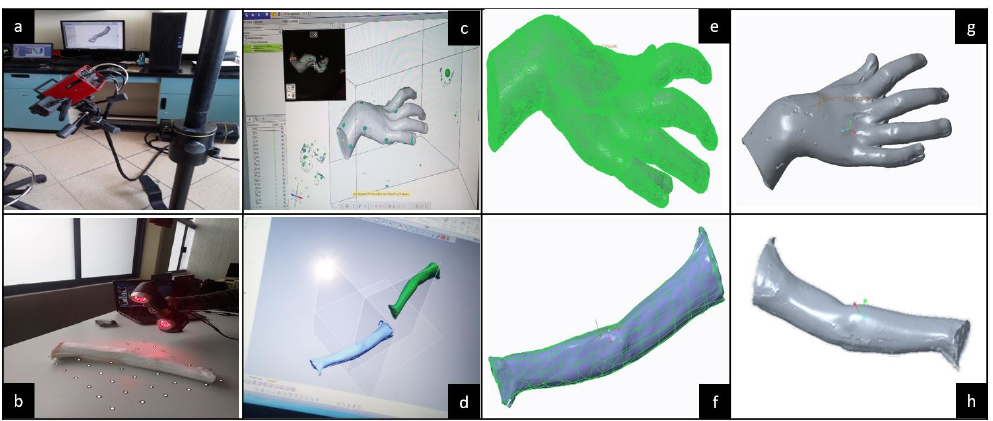
Figure 8. Three dimensional digitalization and virtual modeling ( a , b ) Scanning with ATOS III TM and AMETEK TM . ( c , d ) Hand-forearm computational points cloud were obtained from both sides. ( e , f ) Hand-forearm mesh models. ( g , h ) Hand-forearm solid virtual